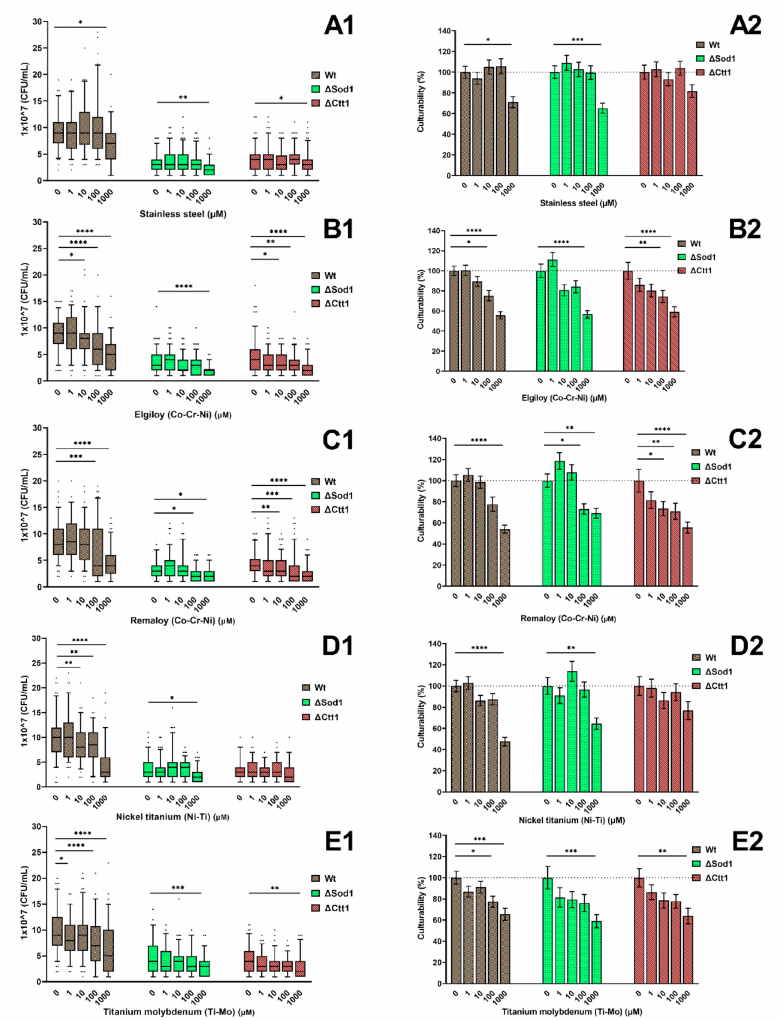
Figure 1. Cell culturability, expressed as CFU / mL, of yeast cells treated with di ff erent compositions and concentrations of metal ions. Wild-type yeast and two yeast mutants ∆ Sod1 and ∆ Ctt1 were subjected to metal ions simulating ( A ) stainless steel, ( B , C ) cobalt-chromium Elgiloy and Remaloy, ( D ) nickel-titanium, and ( E ) β -titanium alloys. The box-plots ( A1 – E1 ) show an absolute values of CFU / mL, while the grouped columns ( A2 – E2 ) present relative values according to the untreated control group. The untreated control group is set at 100%, and the dotted line represents 100% culturability. Significant di ff erences ( p < 0.05 are indicated with * (* p < 0.05, ** p < 0.01, *** p < 0.001, and **** p <